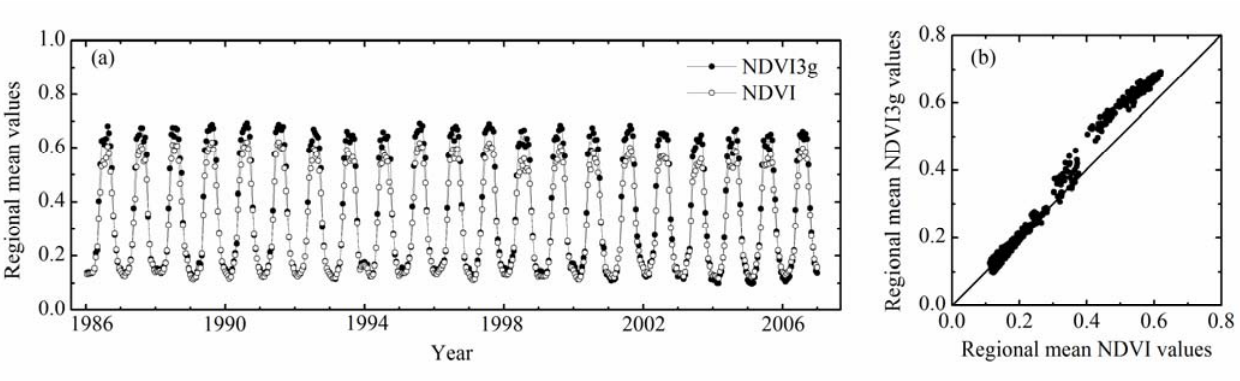
Figure 7. ( a ) Interannual variations of regional mean AVHRR NDVI and AVHRR NDVI3g and ( b ) relationships between regional mean AVHRR NDVI and AVHRR NDVI3g from 1986 to